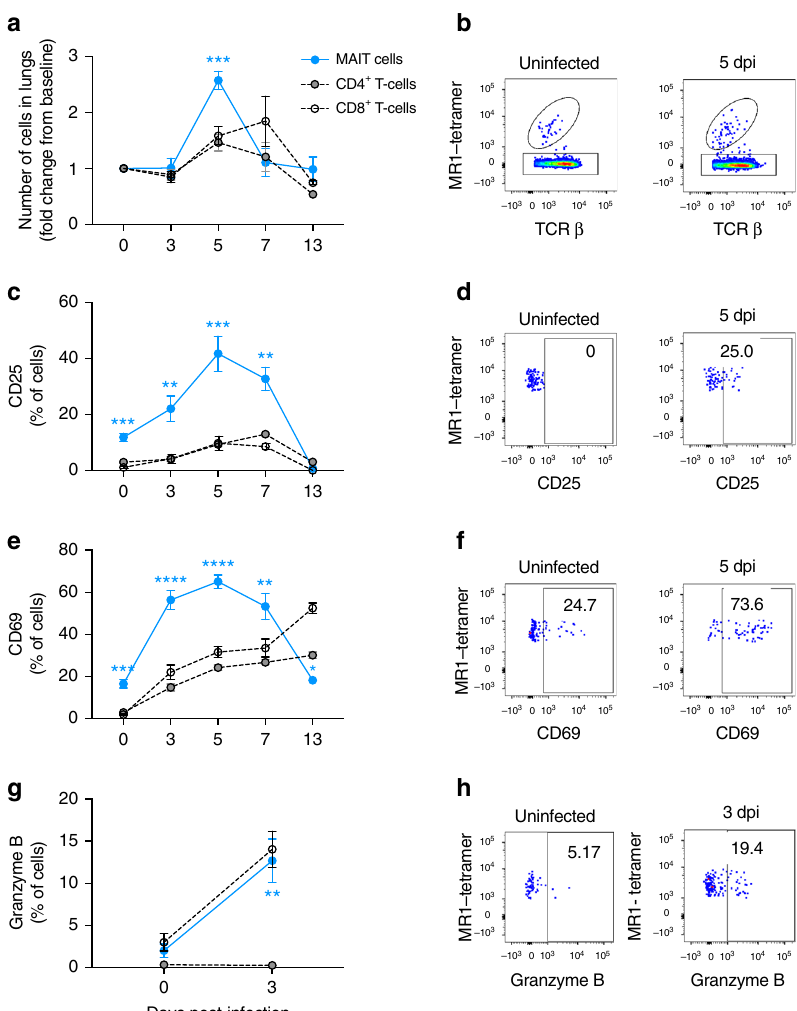
Fig. 1 Early pulmonary MAIT cell accumulation and activation during in fl uenza virus infection. Accumulation and activation of MAIT cells and MR1-5-OP- RU tetramer-negative ‘ conventional ’ CD4 + and CD8 + T cells in C57BL/6 mice before and after challenge with 100 plaque-forming units (PFU) PR8 virus. a Accumulation of pulmonary MAIT cells, CD4 + and CD8 + T cells relative to uninfected day 0 controls at 0, 3, 5, 7, 13 days post-infection (dpi) expressed as fold change from baseline, estimated using calibration particles. b Representative fl ow cytometry plots showing TCR β and MR1-5-OP-RU tetramer staining, gated on live, pulmonary CD45 + 19 − lymphocytes. Proportion of pulmonary MAIT cells expressing c CD25, e CD69 and g Granzyme B expressed as a percentage of MAIT, CD4 + or CD8 + T cells. Representative fl ow cytometry plots show expression of d CD25, f CD69 and h Granzyme B, gated on live pulmonary CD45 + 19 − TCR β + MR1-5-OP-RU tetramer + lymphocytes. Graphs show combined data (mean ± SEM) from four (days 0, 3, 5), two (day 7) or one (day 13) independent experiments with similar results, with 2 – 5 mice per group in each replicate. Statistical tests compare MAIT cell subsets with CD4 + and CD8 + subsets at each time-point by Kruskal – Wallis one-way ANOVA with post hoc Dunn ’ s tests; * P < 0.05, ** P < 0.01, *** P < 0.001, **** P <